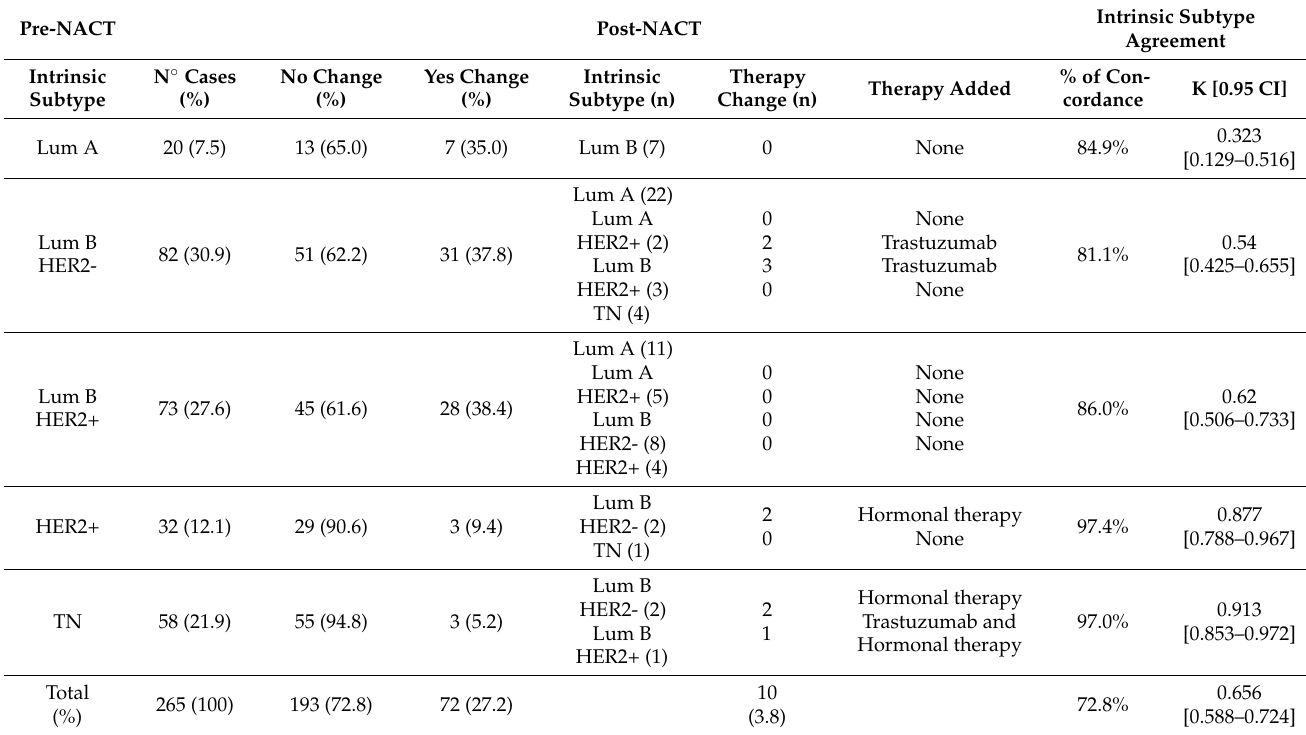
Table 3 describes intrinsic subtype changes and their impact on adjuvant therapy. Table 3. Intrinsic subtype changes and their impact on adjuvant